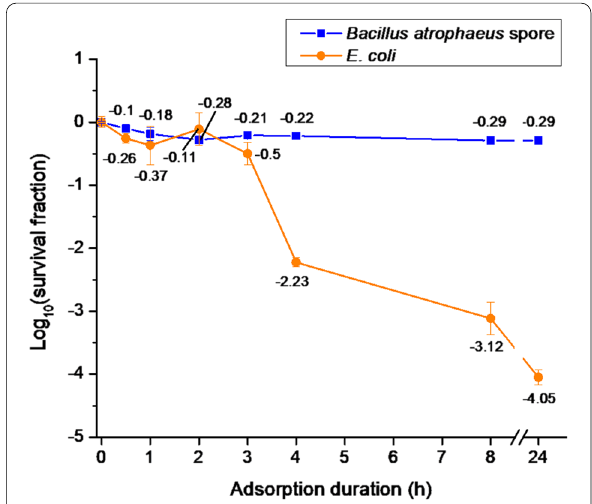
Fig. 3 Effect of adsorption time on KF94 masks on viability of B. atrophaeus and E . coli